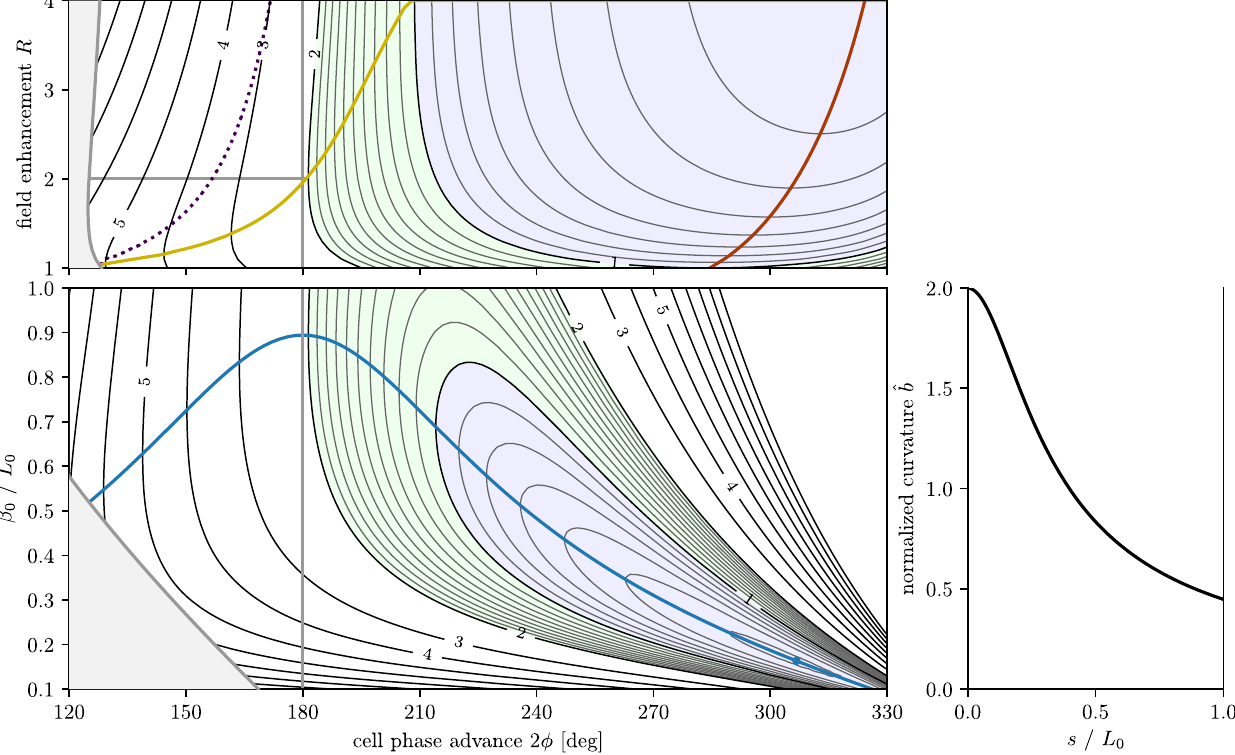
FIG. 5. Properties of the IDM shape. Top: TME emittance ratio F for optimal β 0 in dependence of R , ϕ . The red line shows ϕ given R . The dark-yellow line shows the optimal field enhancement R for given ϕ . Above the dotted line (critical field enhancement), a HOM cell tuned to the LGB-optimal parameters ϕ , β opt 0 yields lower emittance than the LGB cell. The region with F < 1 is shaded in blue (see legend in Fig. 3). Bottom left: F in the ð β 0 ; ϕ Þ plane for an IDM with R ¼ 2 ; the optimum emittance is denoted with a blue dot. Right: IDM on-axis field profile for R ¼ 2